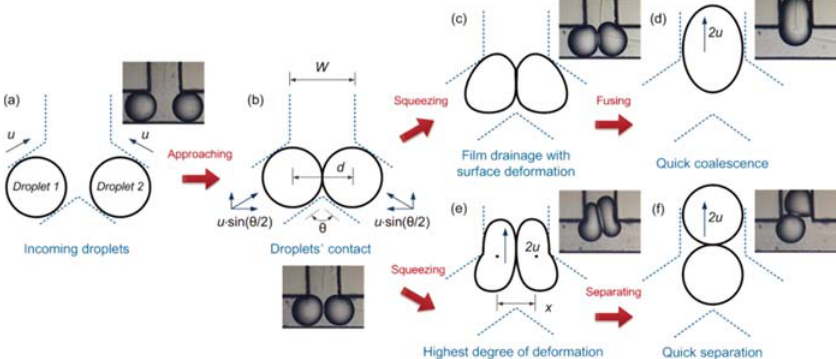
Figure 3. ( a ) droplet flow; ( b ) droplets contact; ( c ) squeezing; ( d ) fused droplet; ( e ) strongest deformation; and, ( f ) separated droplets. Reproduced with permission from [69].